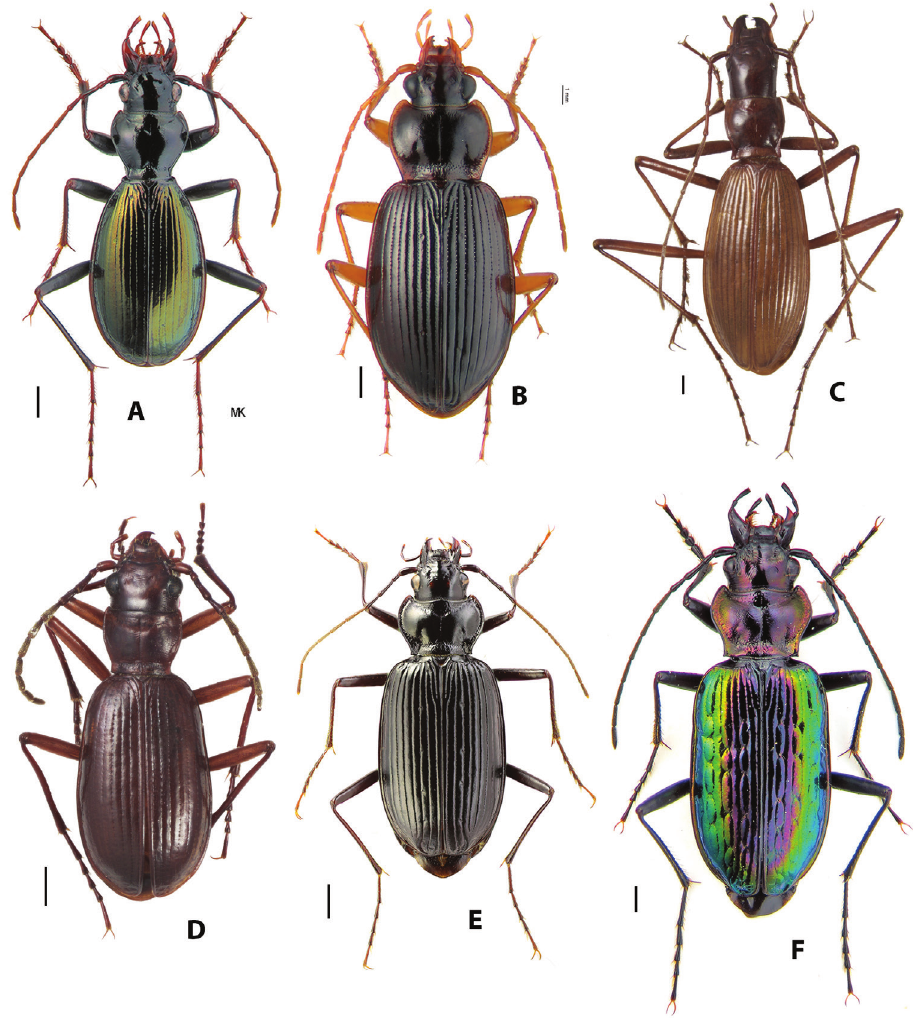
Figure 3. Habitus images of Nebria A N. ( Eonebria ) djakonovi Semenov & Znojko B N. ( Orientonebria ) coreica Solsky C N. ( Spelaeonebria ) nudicollis Peyerimhoff D N. ( Psilonebria ) superna Andrewes E N. ( Reductonebria ) ochotica Sahlberg F N. ( Catonebria ) banksii Crotch. Scale bars: 1.0 mm. Photograph credits: A, B, F Kiril Makarov; C, D David Maddison; E Alexander